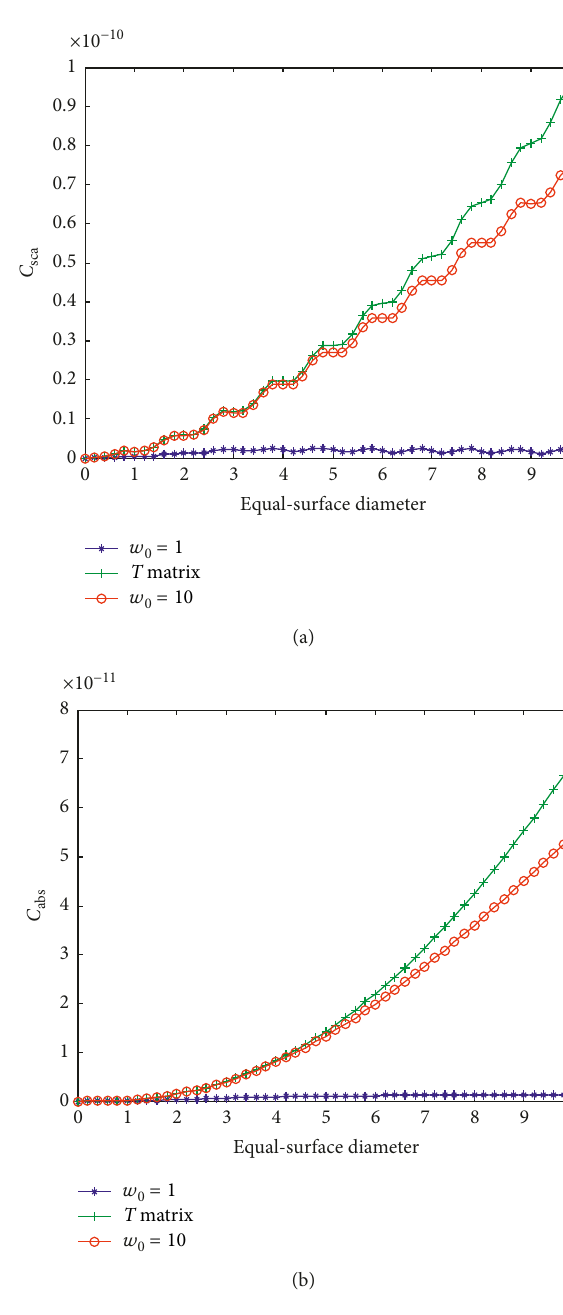
Figure 8: Scattering and absorbing cross sections of spheroid particles ( λ 0.5, m 1.5 +0.01 i (cid:31) (cid:31)